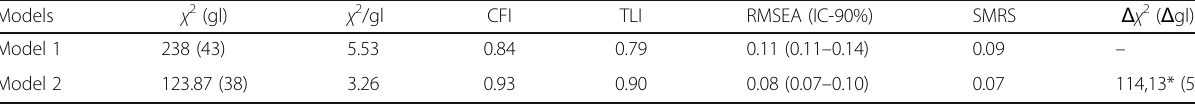
Table 4 Goodness of fit indicators of tested models